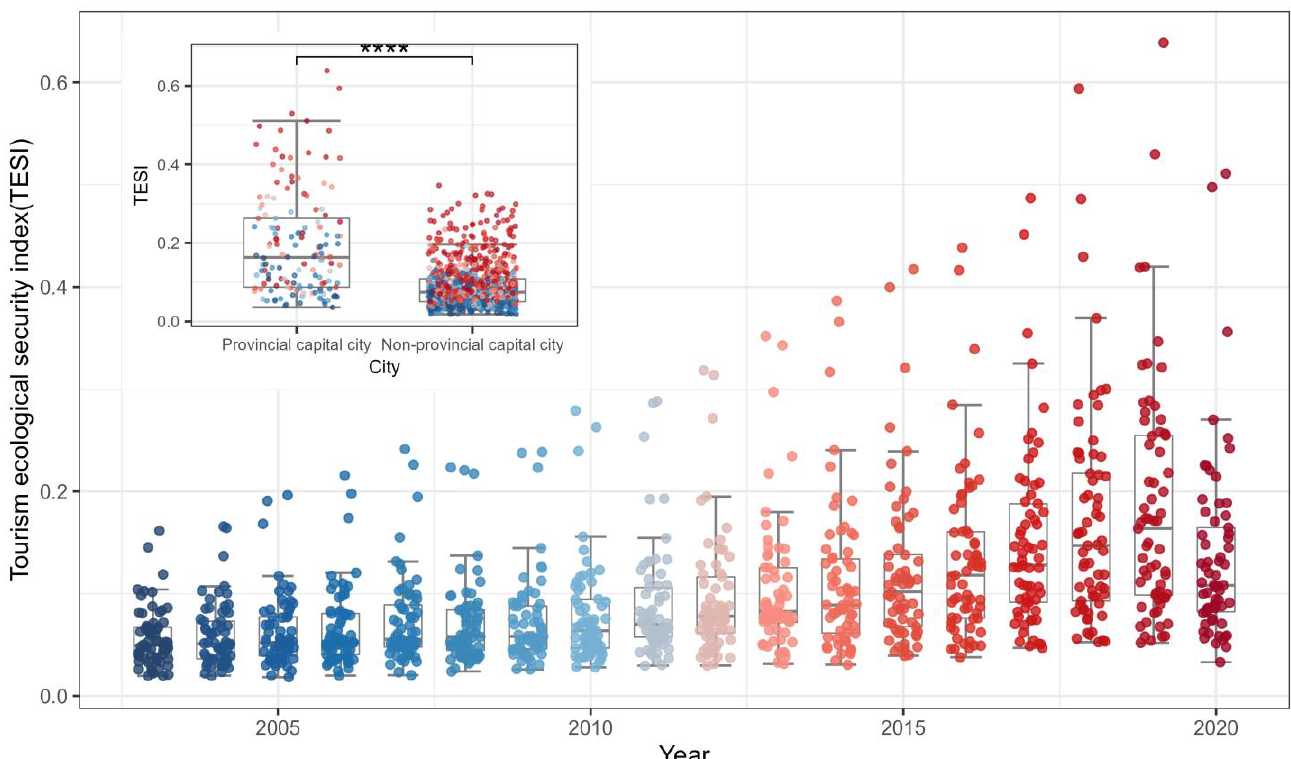
Figure 3. Box plot of the temporal evolution of the municipal tourism eco-security index of the Yellow River basin. **** indicates a significance of 0.0001.